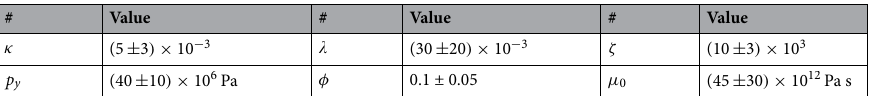
Table 3. Different parameters chosen to study their influence of